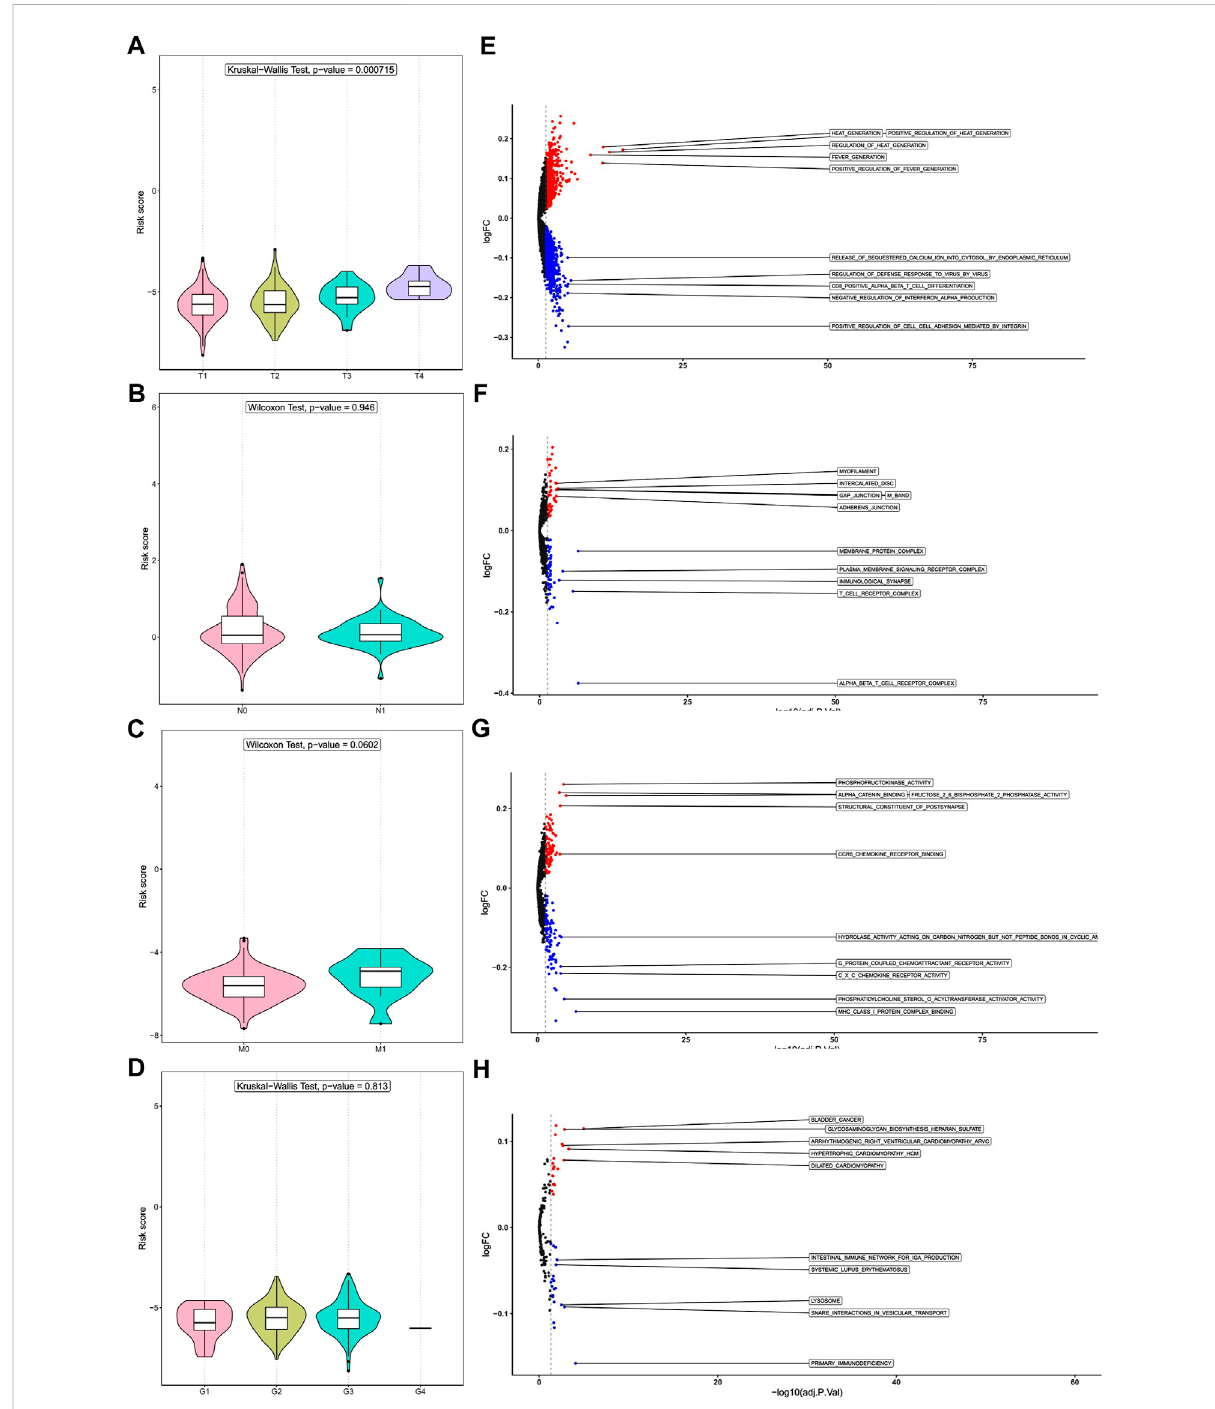
FIGURE 7 Riskscoreandtumorstagesandgenesetenrichmentanalysis(GSEA).Differenceinriskscoreamong (A) Tstages, (B) Nstages, (C) Mstages,and (D) grades. Differences in pathway enrichment in tumors of patients in the high- and low-risk groups: (E) Gene Ontology (GO) analysis of biological processes, (F) GO analysis of cell components, and (G) GO analysis of molecular functions. (H) Kyoto Encyclopedia of Genes and Genomes (KEGG) enrichment